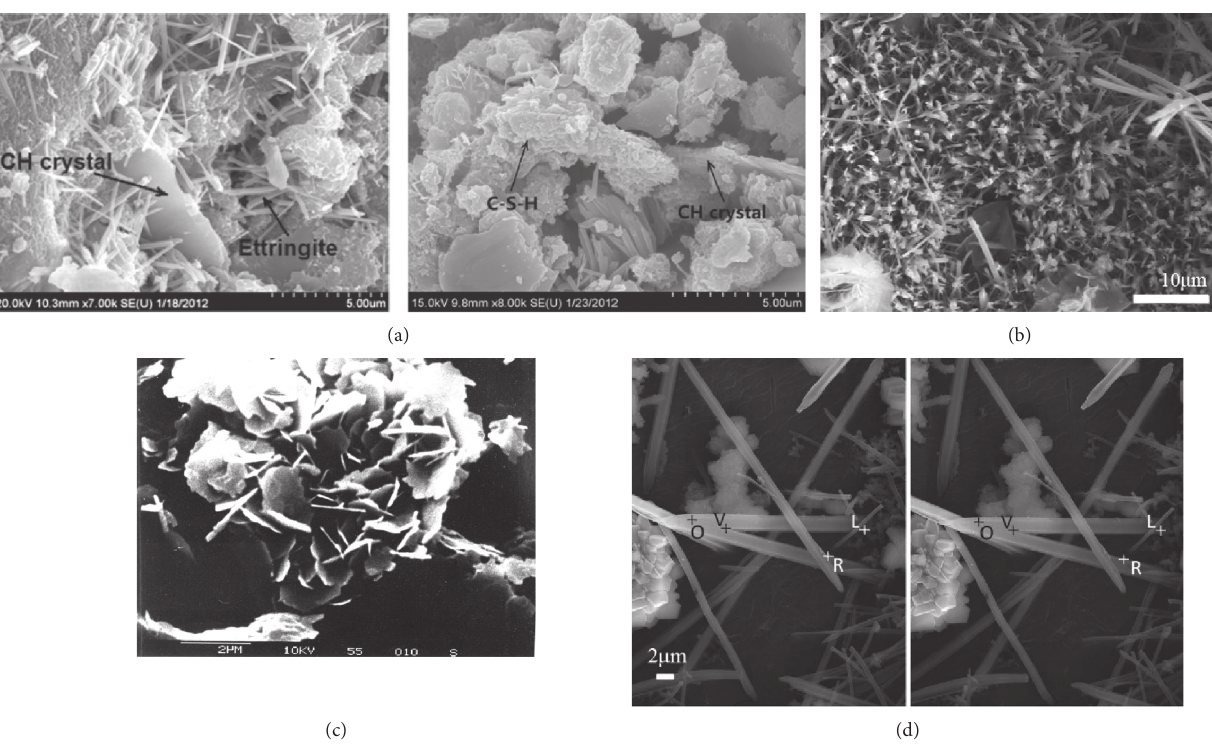
Figure 1: Micromorphology of components in ITZ [20, 28, 29]. (a) Micromorphology of ITZ [28]. (b) Micromorphology of CSH [20]. (c) Micromorphology of CH [29]. (d) Micromorphology of ettringite